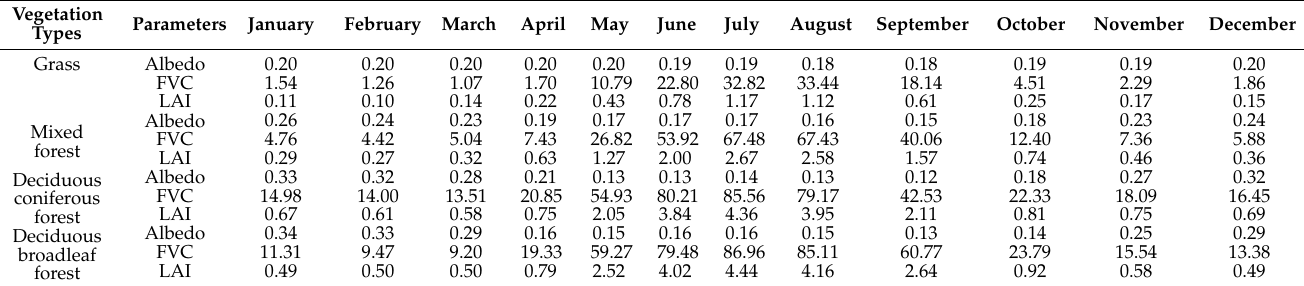
Table 1. The regional statistical monthly mean albedo, FVC (%), and LAI (m 2 /m 2 ) for grassland and forests. Vegetation